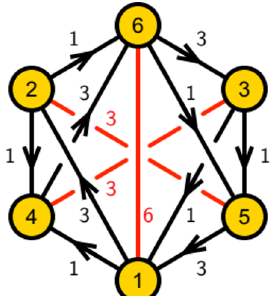
Figure 14 . Quiver for Model